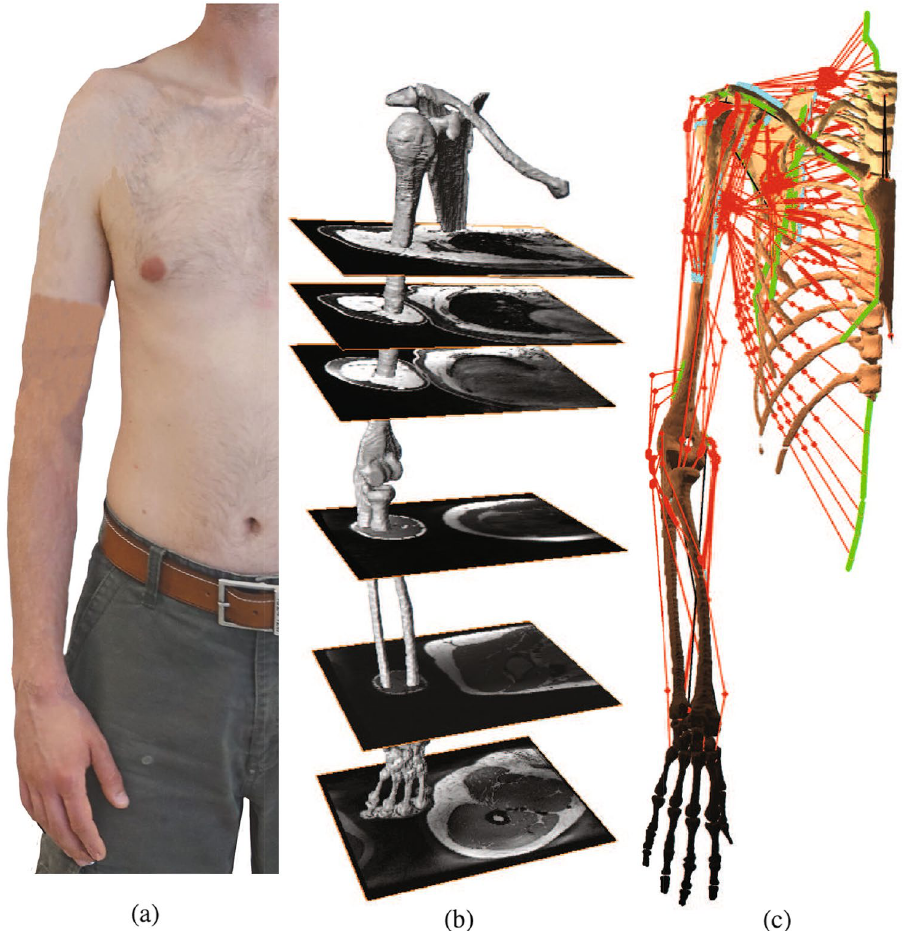
Figure 2. The developed shoulder and elbow model. ( a ) The anthropometric data of a healthy male subject is used to develop the model. ( b ) The bone morphologies and muscles origins/insertions are deduced from MRI scans of the same subject. ( c ) The model consists of thorax, clavicle, scapula, humerus, ulna, radius, and a hand tied to the radius. It has nine DOF represented by eleven generalized coordinates and two holonomic constraints. The model includes 42 muscles that can be represented by up to 20 massless elastic strings. Muscle origins and insertions are denoted by green and blue areas,